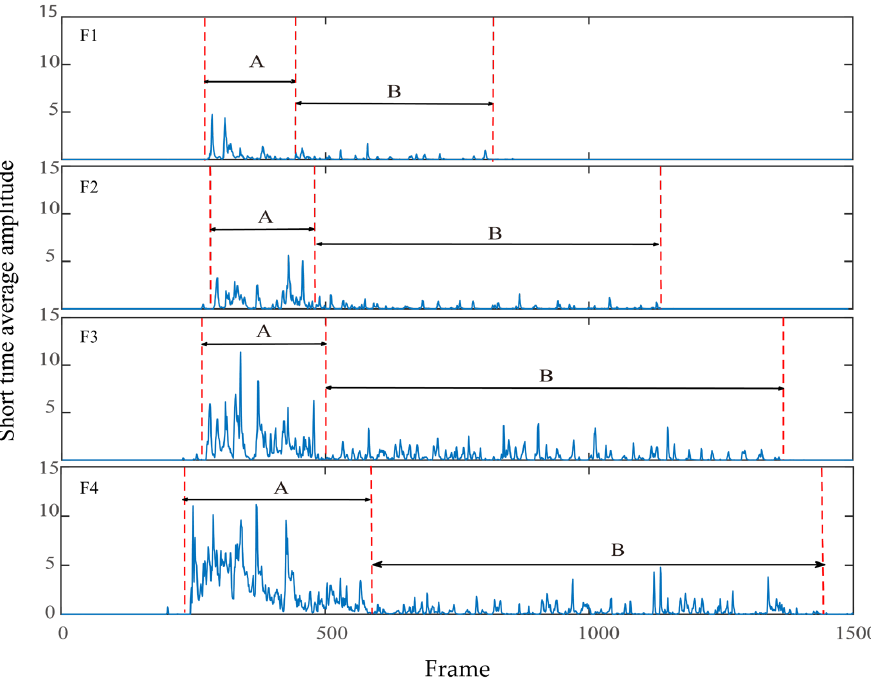
Figure 5. Short-time average amplitude of largemouth bass feeding call (A is the ingestion stage; B is the chewing stage): F1 represents the experimental group of breeding density of 4; F2 represents the experimental group of breeding density of 8; F3 represents the experimental group of breeding density of 12; F4 represents the experimental group of breeding density of 16.